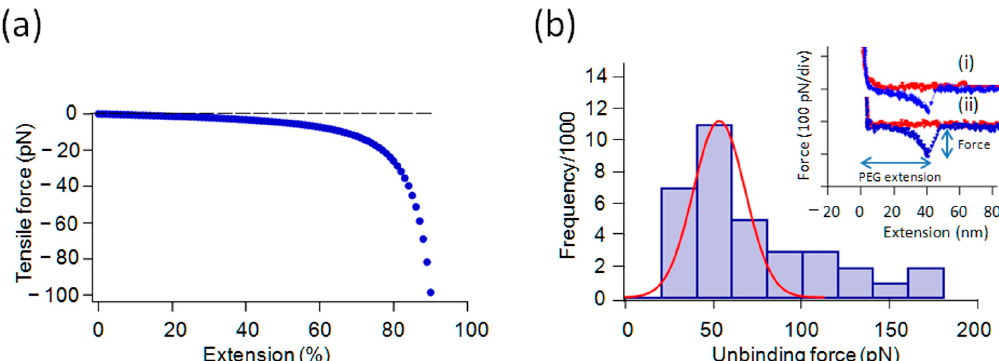
Figure 3. Theoretical polymer extension curve and results of Gly and di-Gly unbinding. ( a ) An expected force-extension curve of flexible polymer modeling the PEG spacer behavior up to 95% extension of the total contour length (based on the worm-like chain model [38], with the persistence length of 0.1 nm); ( b ) (inset curves) force curves of monomeric Gly (i) and di-Gly (ii) in the approach regime to the pyrite surface (red) and the retracting regime from the surface (blue). The ordinate is the force detected as the product of the cantilever deflection (nm) and its spring constant (N/m). The initial non-linear deflection due to the extension of the PEG crosslinker is abruptly terminated and the force jumped to zero. The final rupture force was identified as the unbinding force. Only those force peaks observed between 15 and 60 nm of extension were considered to be representing positive interactions and collected for further analysis; (main figure) Histogram of unbinding force for di-Gly, which gave the most probable force (MPF) of ~50 pN as the mode of Gaussian fitting curve in red. The frequency of observing unbinding force peaks matching our criteria was too low for monomeric Gly to construct a meaningful histogram.